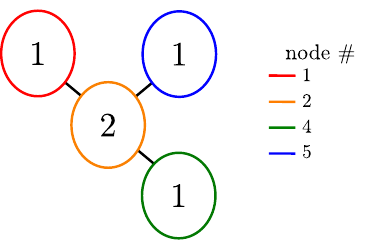
Figure 6. The result of U(1) 3 con(cid:12)nement in the D 4 quiver of (cid:12)gure 5.